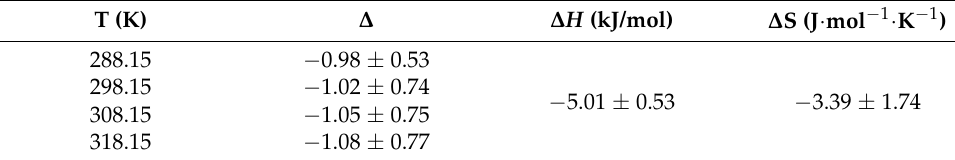
Table 4. Thermodynamic parameters for the adsorption of MB onto